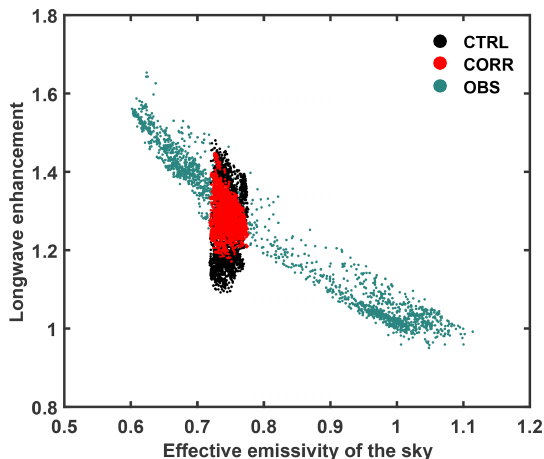
Figure 5. Longwave enhancement measured (OBS; green) at the forest stand of Alptal, Switzerland, and simulated in CTRL (black) and CORR (red) for boreal evergreen needleleaf trees in the corre- sponding grid cell of Alptal, Switzerland, as a function of effective emissivity of the sky. Each data point represents an hourly average seen in Fig.